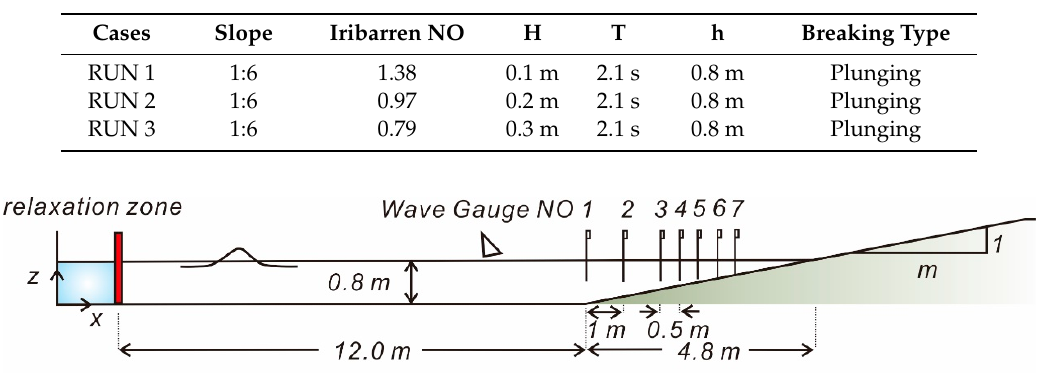
Figure 5. Computational domain and location of wave gauges [Gauge NO. 1: x = 12.0 m, Gauge NO. 2: x = 13 m, Gauge NO. 3: x = 14 m, Gauge NO. 4: x = 15